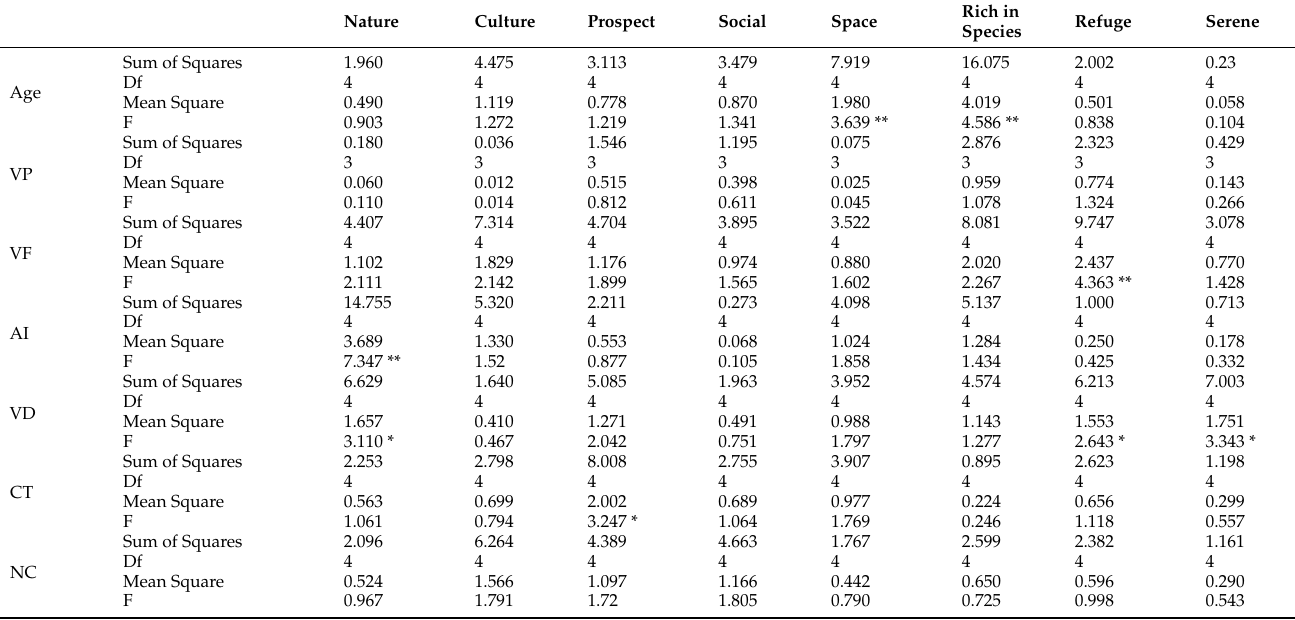
Table 7. The results of ANOVA with age and VCs as independent variables and the PSDs as depen- dent variables. Nature Culture Prospect Social Space Rich in Species Refuge Serene